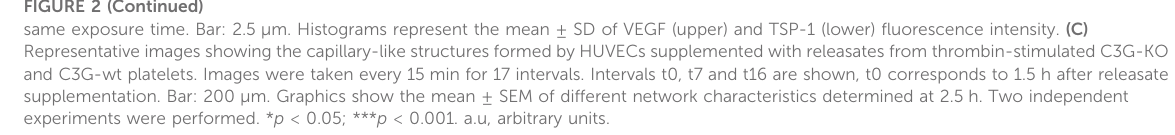
FIGURE 2 (Continued) same exposure time. Bar: 2.5 μ m. Histograms represent the mean ± SD of VEGF (upper) and TSP-1 (lower) fl uorescence intensity. (C) Representative images showing the capillary-like structures formed by HUVECs supplemented with releasates from thrombin-stimulated C3G-KO and C3G-wt platelets. Images were taken every 15 min for 17 intervals. Intervals t0, t7 and t16 are shown, t0 corresponds to 1.5 h after releasate